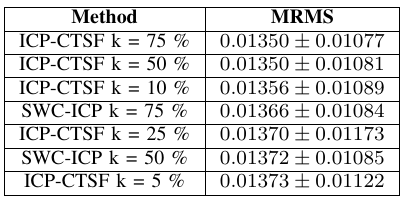
TABLE XIII: Best seven methods for video ‘freiburg2 rpy’ according to the MRMS given by expression (41).